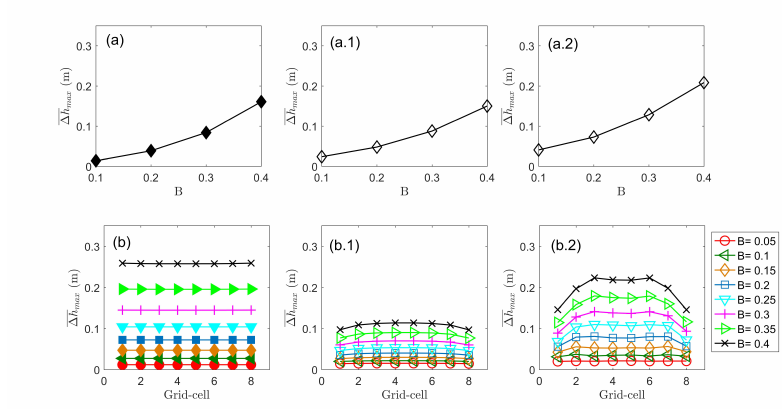
Figure 5. Maximum head drops across a fence ( a ) and partial fence ( b ); analytical (filled markers) and numerical solutions (un-filled markers) obtained from ADI (*.1) and TVD (*.2) models.